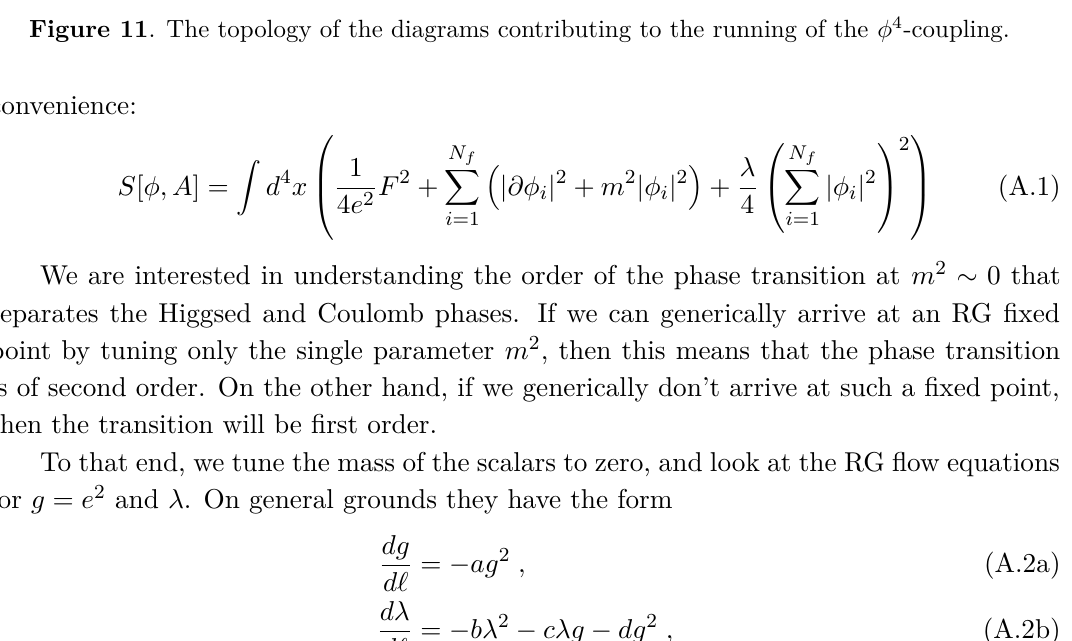
Figure 11 . The topology of the diagrams contributing to the running of the φ 4